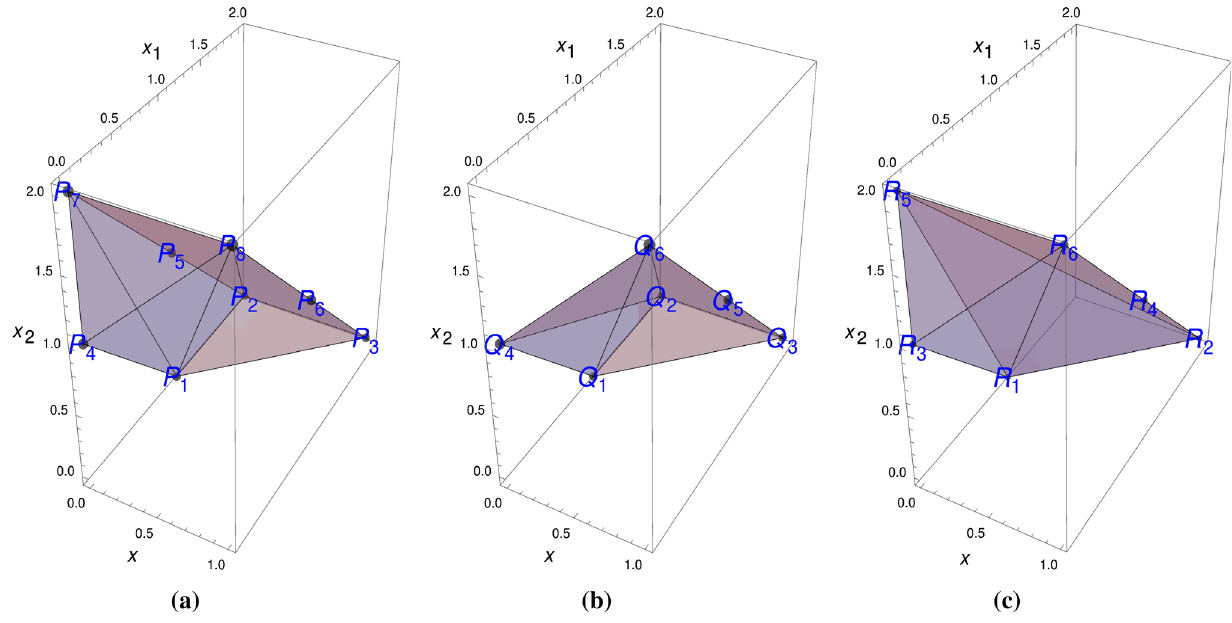
Fig. 7 From left to right – Newton polytopes for G 1 , G 2 and G